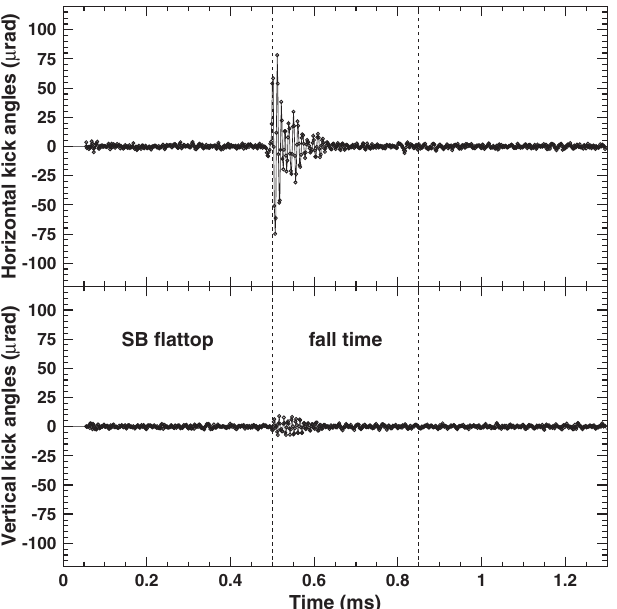
FIG. 20. Kick angles of the dipole field ripple evaluated after the improvement of the SB power supply.